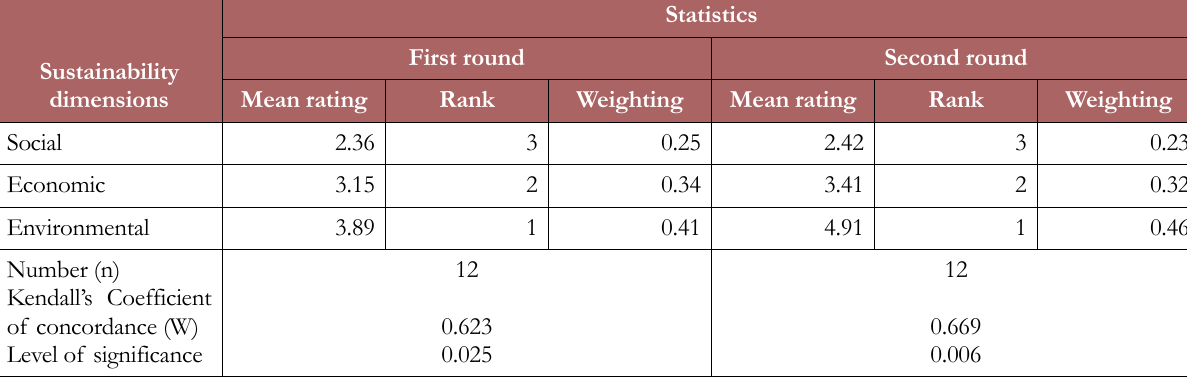
Table 3. Results of round 1 and round 2 of Delphi technique for the importance of sustainability dimensions